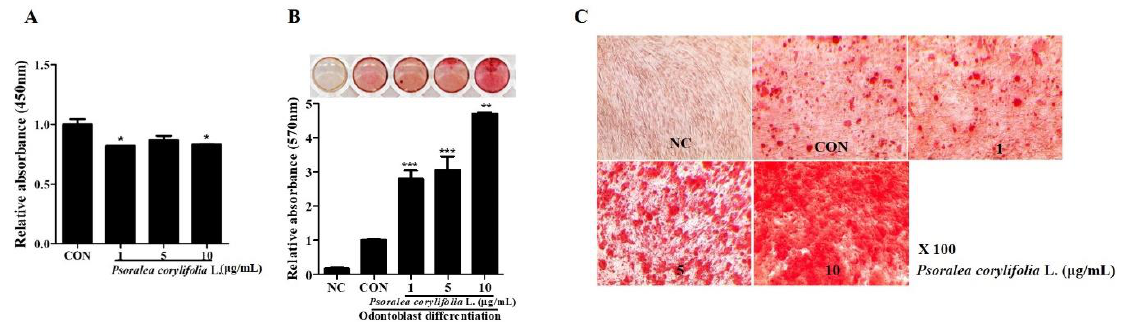
Figure 1. Effect of P. corylifolia extracts on proliferation and odontogenic differentiation in hDPSCs ( A ) Cell proliferation was measured at 4 days using the CCK-8 assay. When treated with 1, 5, and 10 µ g/mL of P. corylifolia extracts, cell proliferation was comparable with the control group. All data are presented as the mean ± SEM. * p < 0.05. ( B ) Alizarin red S (ARS) staining was performed on the 10th day of odontogenic differentiation of hDPSCs exposed to P. corylifolia . All data are presented as the mean ± SEM (n = 3). ** p < 0.02, *** p < 0.01. ( C ) Scanned images of plate wells are presented above the quantitation graph of ARS staining. The values obtained for P. corylifolia extract-treated group were compared with those of the positive control. ( C ) 100 × microscopic images of hDPSCs treated with 1, 5 and 10 µ g/mL of P. corylifolia extracts. SEM, standard error of mean; NC, negative control; CON, positive control; hDPSCs, human dental pulp stem